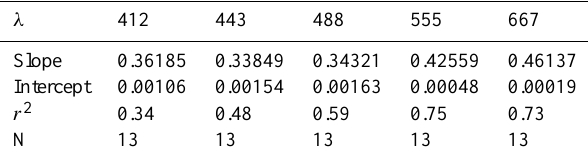
Table 2. Slopes, intercepts, and r 2 between MODIS and in situ- measured R rs (λ)